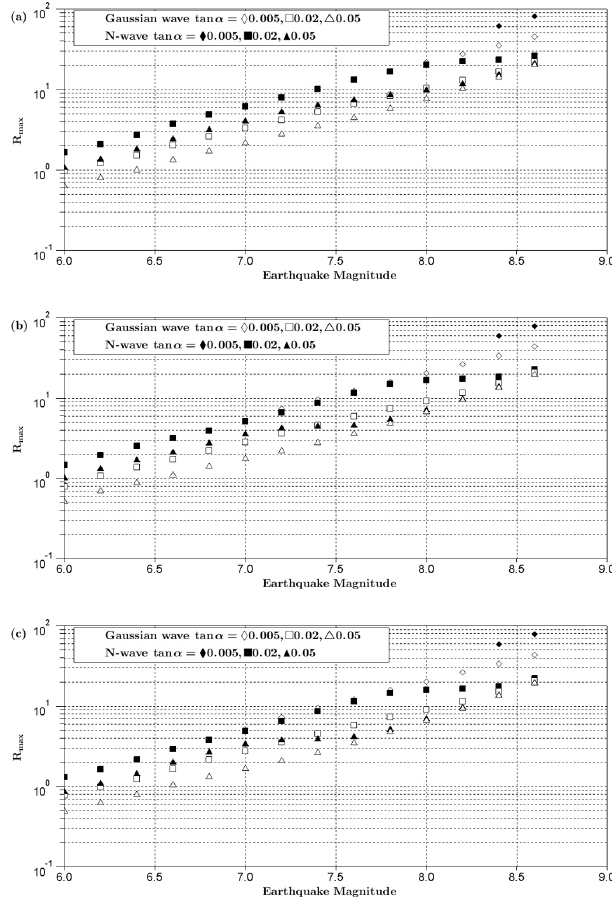
Fig. 5. Maximal run-up height (in m) versus the earthquake magni- tude for Gaussian impulses and N wave impulse for x 0 = 40km (tan α = 0 . 005), x 0 = 10km (tan α = 0 . 02), x 0 = 4km (tan α = 0 . 05), h 0 = 4000m, and h 1 = 200m for different inclinations of continental shelf and continental slope: (a) tan α = 0 . 1 ( x 2 = 40km), (b) tan α = 0 . 5 ( x 2 = 8km), and (c) tan α = 3 ( x 2 = 1 .